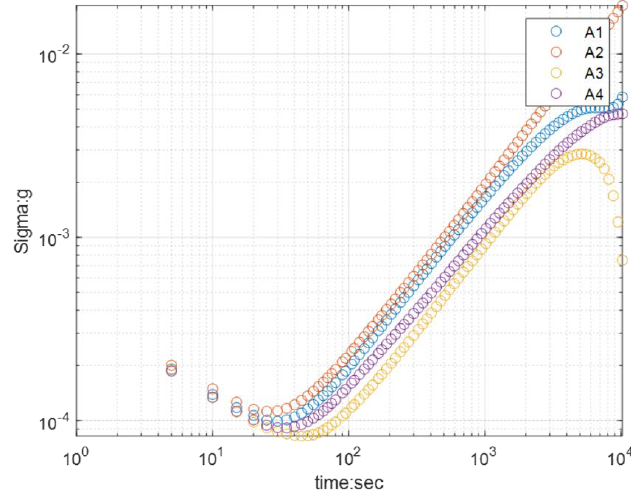
Figure 10. Allen’s variance statistics of zero bias.